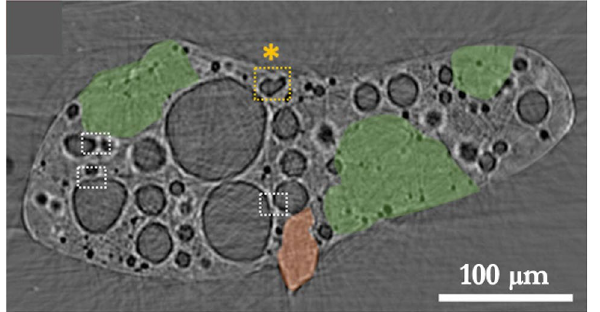
Figure 10. Synchrotron radiation XRT image of the inner structure of a ‘Type B’ CsMP. Marked by the white and yellow boxes are the locations where voids connect or coalesce, respectively. The Fe-rich region of the particle is highlighted in orange, while the green region marks Ca-rich, low porosity areas. From 21